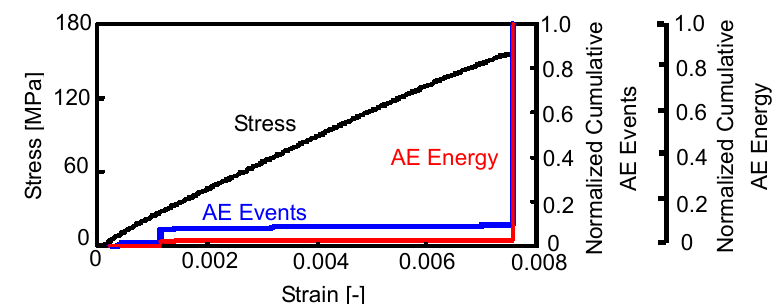
Fig. 4. Stress-strain relationship and AE behaviors during static compression